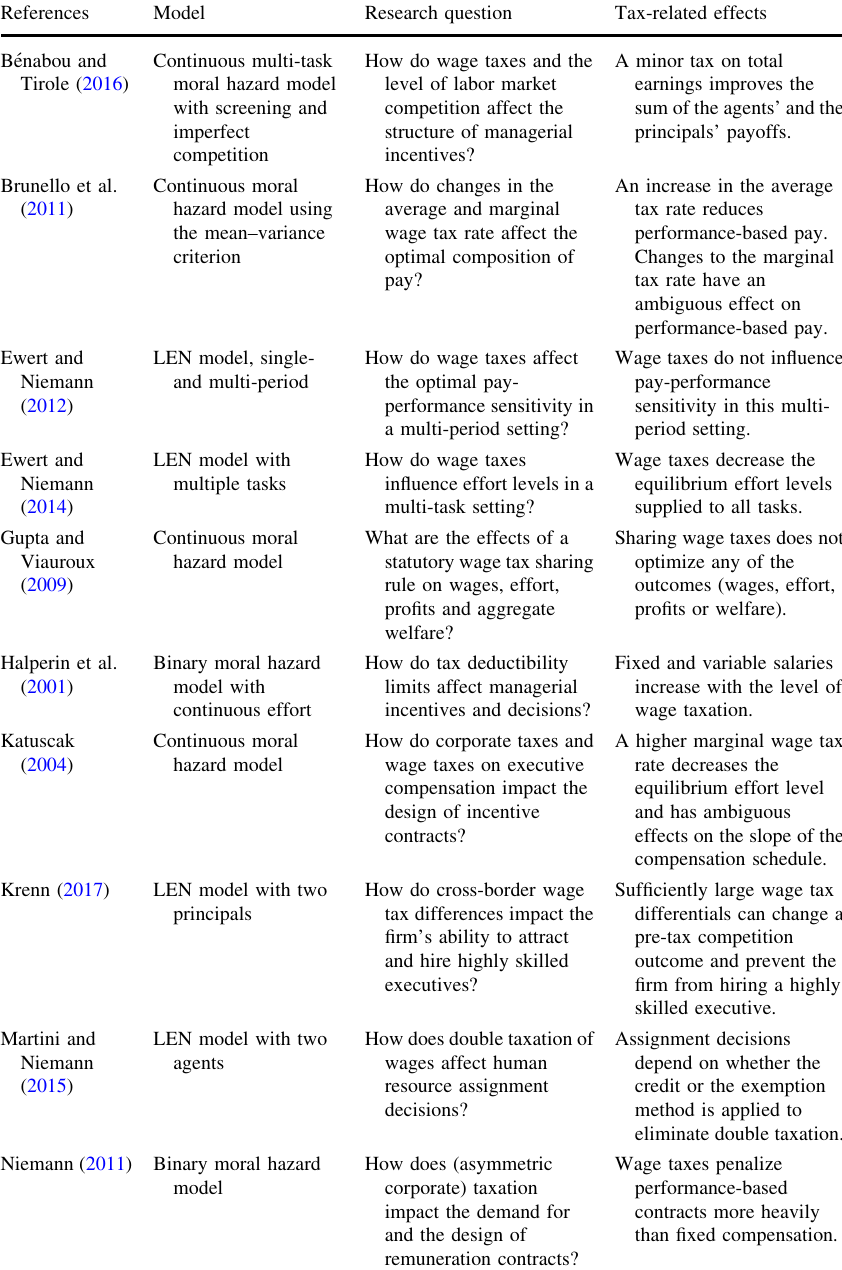
Table 6 Wage taxes and the design of compensation